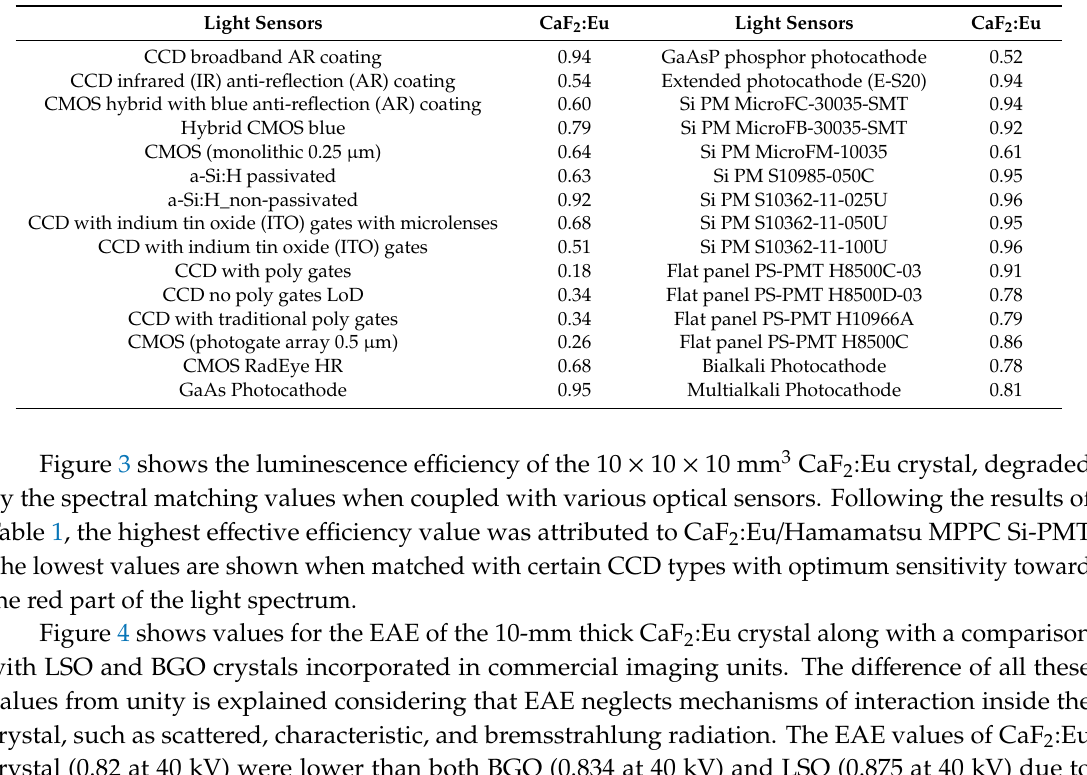
Table 1. Spectral matching factor